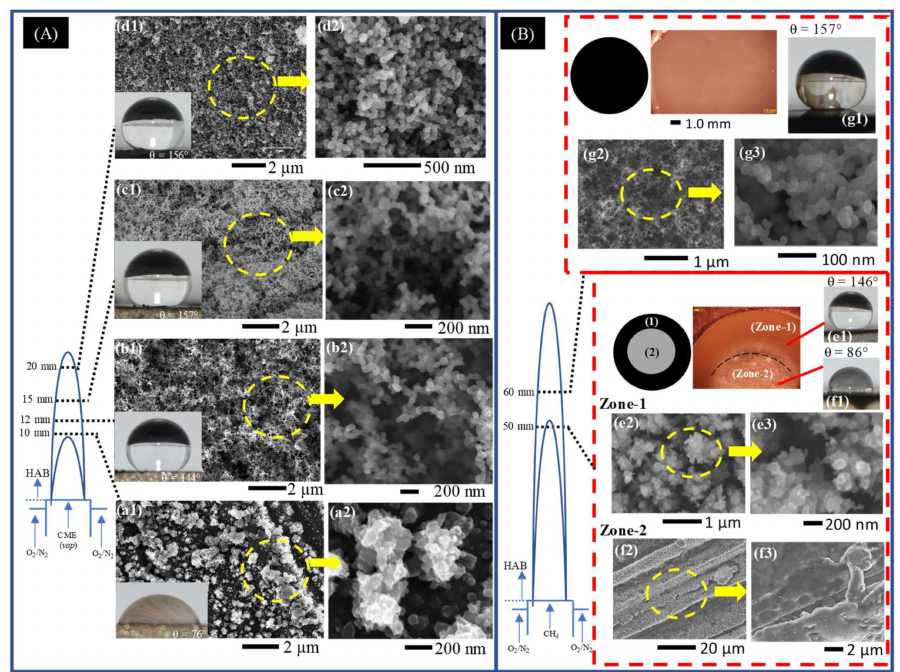
Figure 3. Representative SEM images of early soot deposits to fully developed hydrophobic films deposited on the surface of the SS substrate introduced at various HAB for a ( A ) CME/air and ( B ) CH 4 /air flames. ( A ) Deposits formed in Flame I at HAB of 10 mm (a1,a2), 12 mm (b1,b2), 15 mm (c1,c2), and 20 mm (d1,d2) for a substrate residence time of 5 min. ( B ) Deposits formed in Flame II at HAB of 50 mm (Zone-1 (e1–e3) and Zone-2 (f1–f3)) and 60 mm (g1–g3) for a substrate residence time of 1